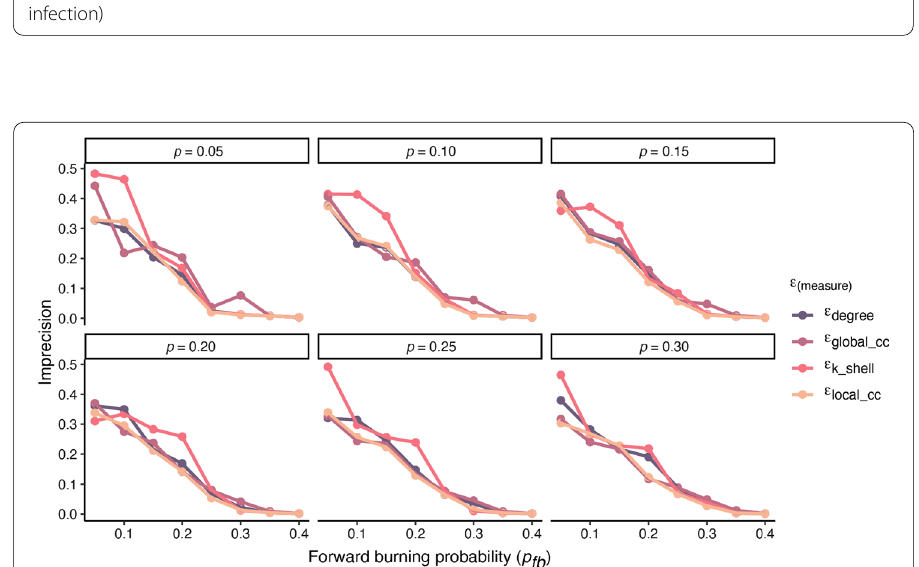
Fig. 7 Imprecision of estimating the infection of the p top nodes. Values on the x-axis correspond to the p fb value used to generate our 8